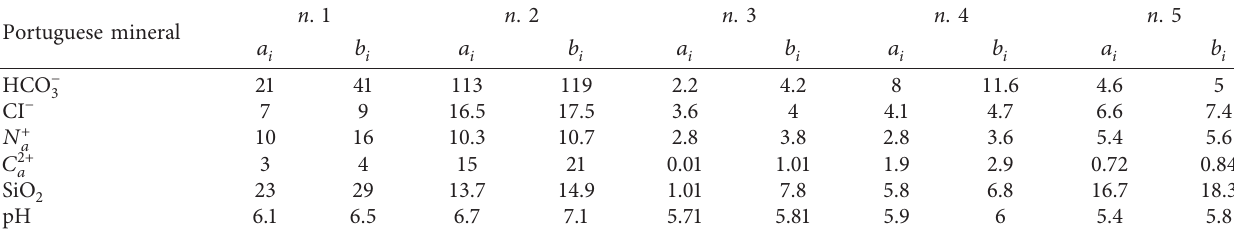
Table 1: The PMW data.